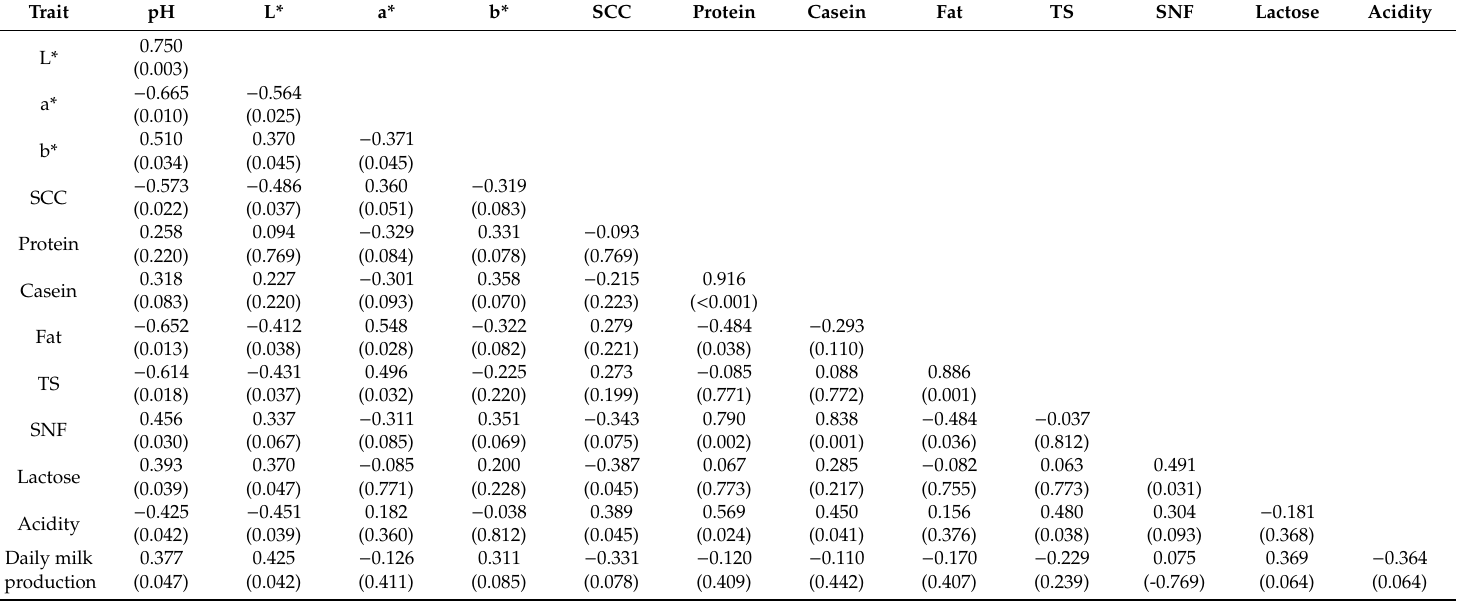
Table 5. Pearson correlation coe ffi cients between daily milk production and milk quality characteristics ( p -values).